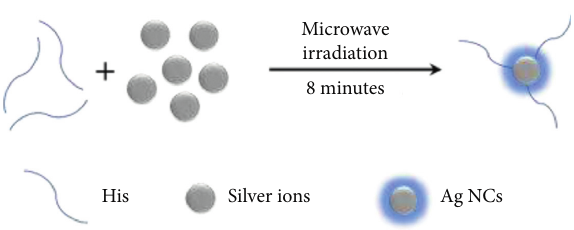
Scheme 1: Schematics of the formation of the Ag NCs.